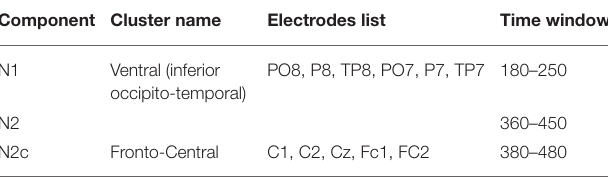
TABLE 1 | Electrodes clusters composition.